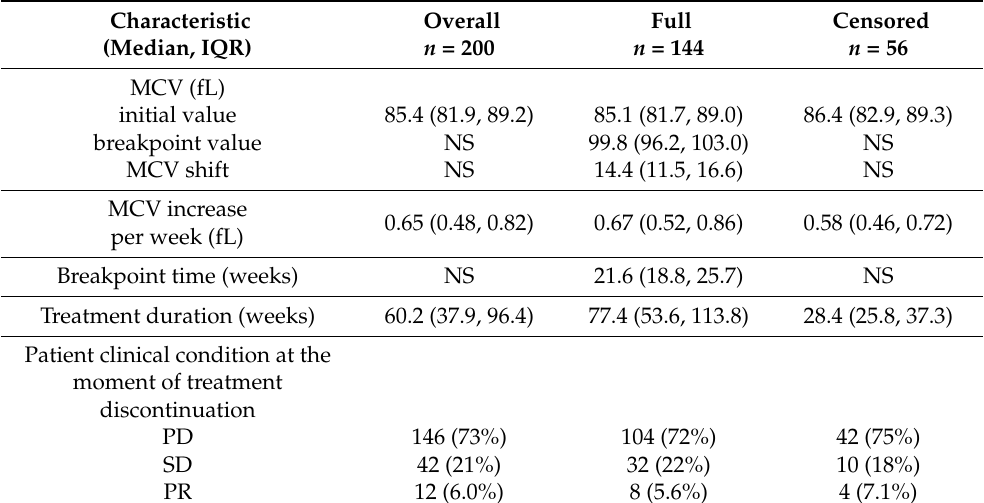
Table 2. Treatment period characteristics and observed parameters of MCV